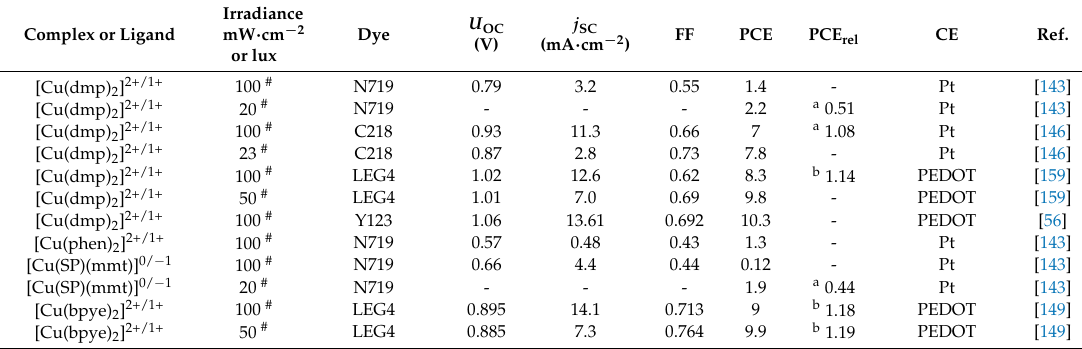
Table 2. Photovoltaic data for the devices employing copper redox mediators. The relative efficiency values PCE rel are calculated as PCE rel = PCE/PCE ref where PCE ref is the PCE of a cell with a reference